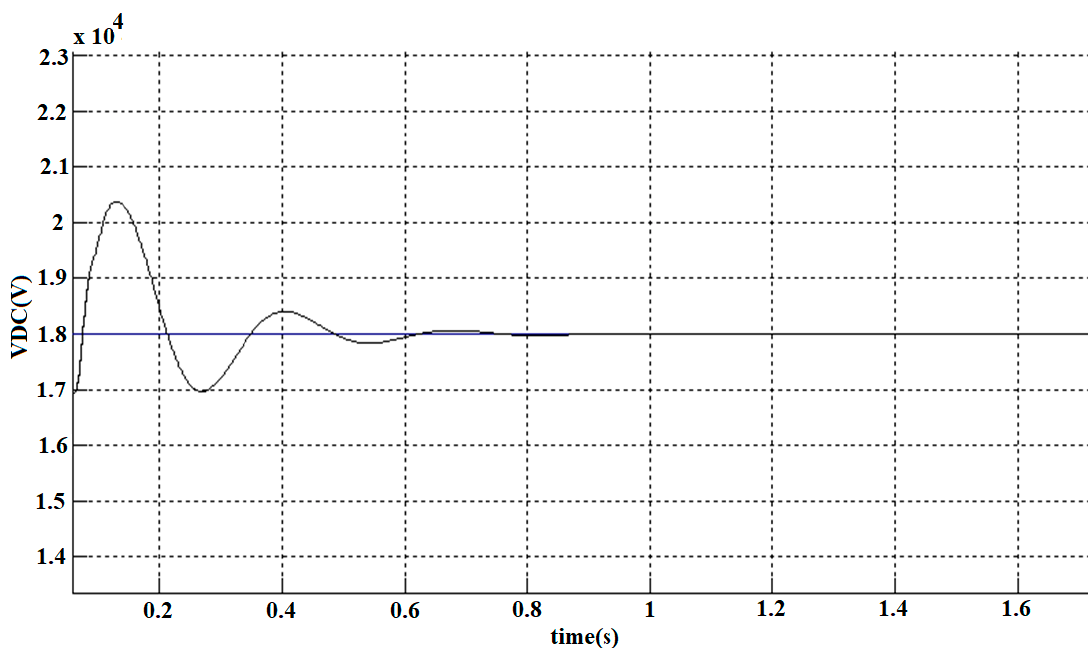
Figure 20. Vdc tracking waveform.